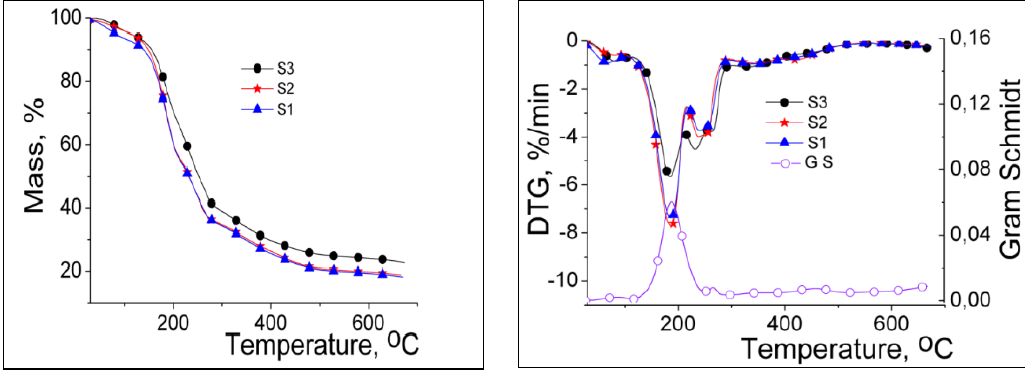
Figure 4. TG and DTG curves of PITAU–Alg gels.